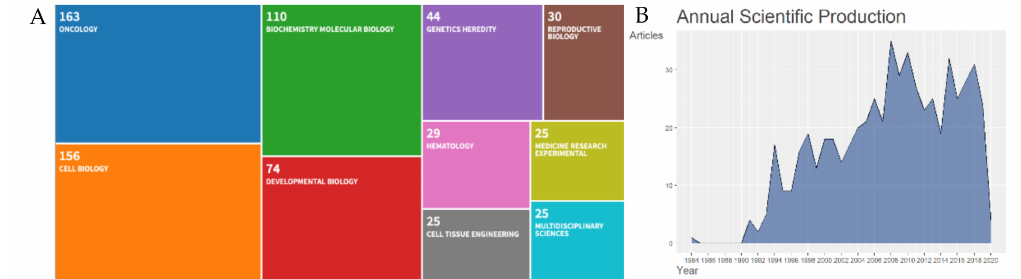
Figure 1. ( A ) Web of Science (WoS) categories. Visual representation of classification methods for scientific literature on Cripto research. Ten fields of knowledge were retrieved from the WoS repository: Oncology ( n = 163), biochemistry and molecular biology ( n = 110), genetics heredity ( n = 44), reproductive biology ( n = 30), cell biology ( n = 156), developmental biology ( n = 74),